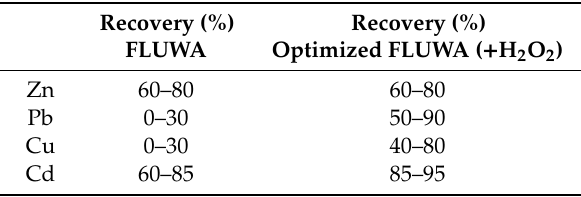
Table 1. Average metal recovery achieved by acidic leaching with the FLUWA process